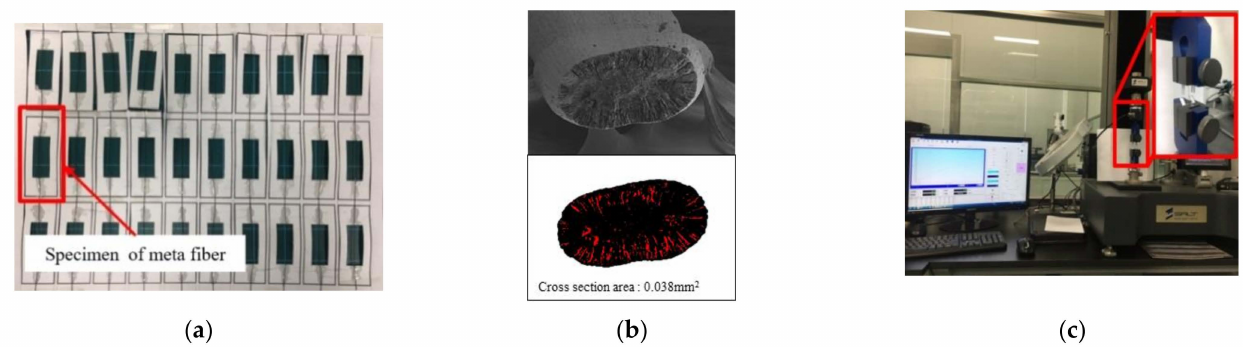
Figure 2. Process of CNT/PVDF fiber tensile tests. ( a ) Preparation of CNT/PVDF fiber; ( b ) Measurement of the CNT/PVDF fiber cross-sectional area; ( c ) CNT/PVDF fiber tensile tests.